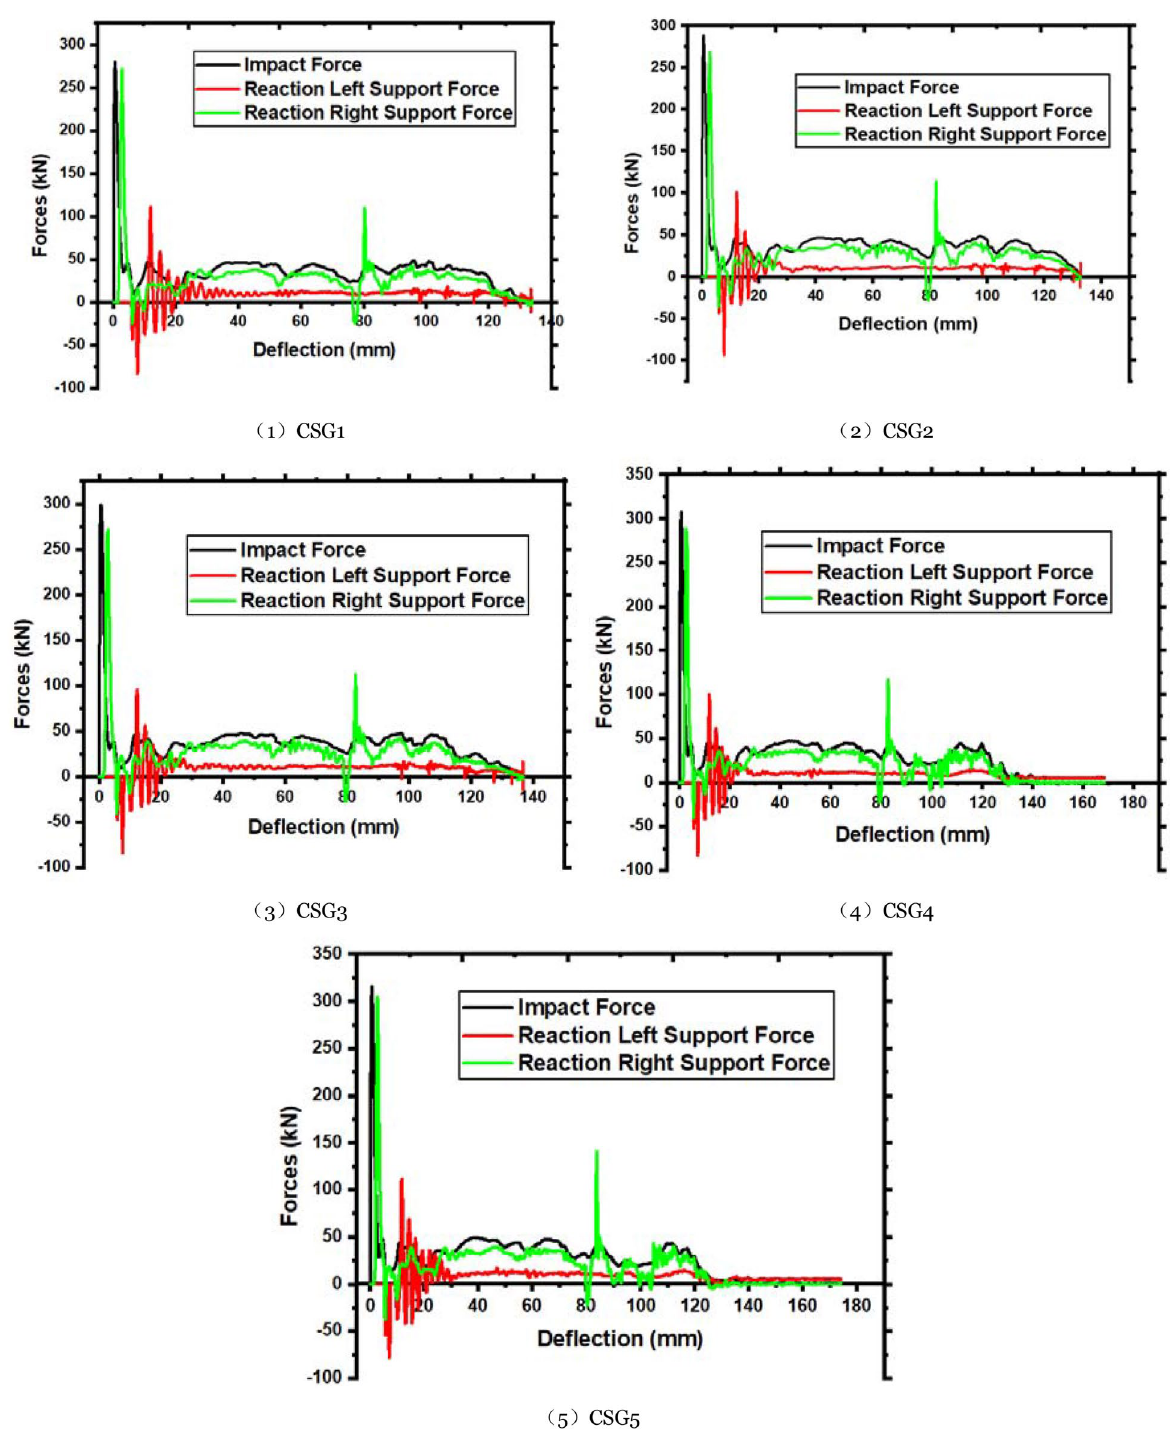
Figure 14. Force–deflection curves of different concrete strength